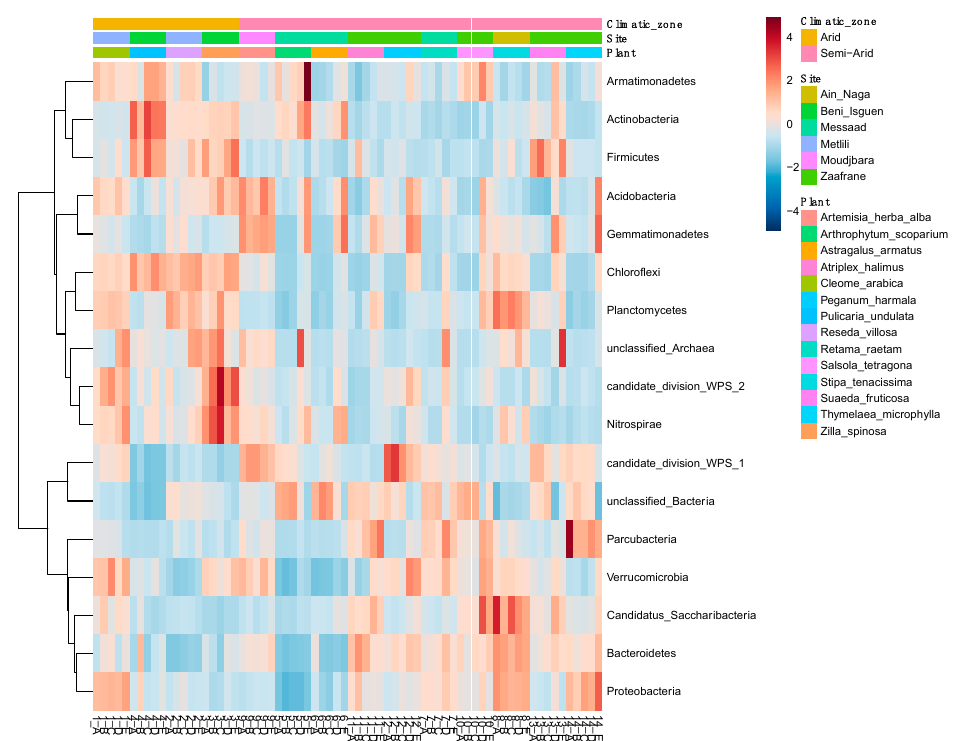
Figure 4. Heatmap at phylum level. Clustering result shown as heatmap (distance measure using euclidean and clustering algorithm using ward.D) at phylum level. Hierarchical clustering is performed with the hclust function in stat package of MicrobiomeAnalyst.